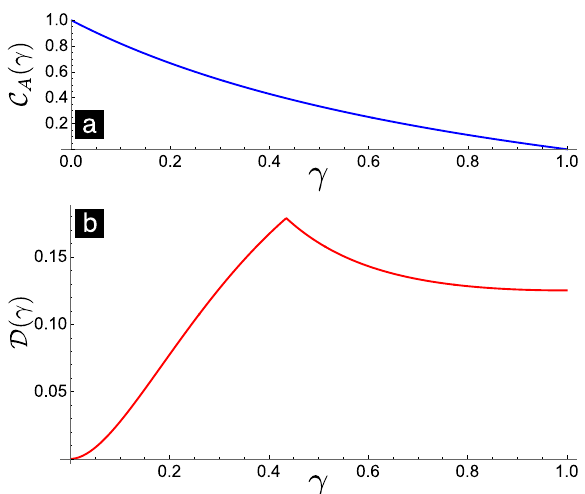
Fig. 5 Theoretically obtained properties of the post-selected bipartite output state as a function of the intensity mismatch γ . a The single-qubit coherences decrease as the intensity mismatch γ goes from 0 to 1. b The geometric discord is maximum for γ ≈ 0.435, when the two input WCSs have unequal intensities.